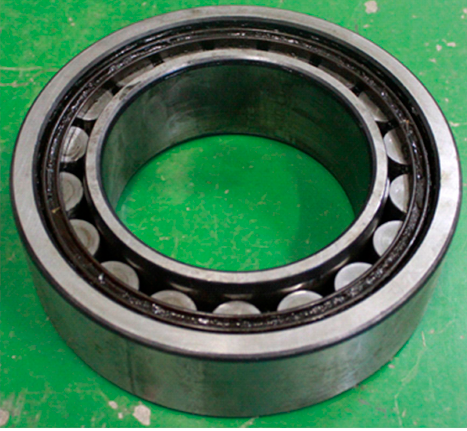
Figure 7. The outer ring fault bearing